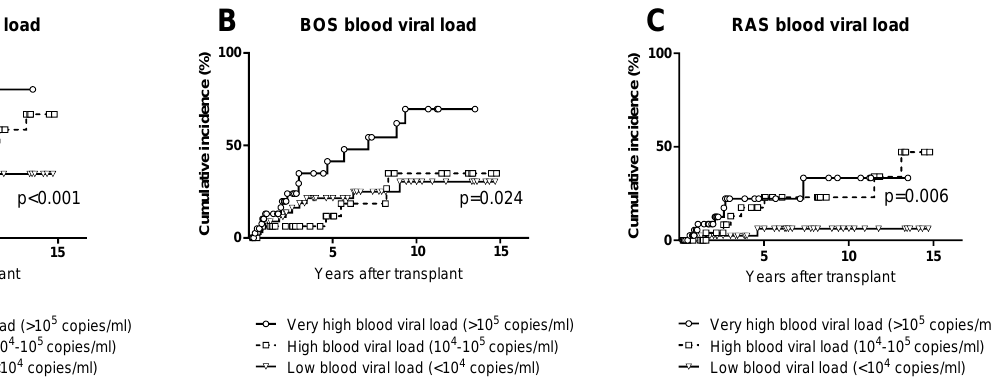
Figure 3. Cumulative incidence of CLAD in ( A ) patients who experienced acute rejection or no acute 10-year cumulative incidence of CLAD was not different between 16 patients in whom rejection; ( B ) patients who developed a CMV load in the blood above or below the median level; ( C ) CMV DNA was never detected (35%) and 32 patients with positive CMV DNA in the patients who developed a CMV load in the BAL above or below the median level. blood (38%).